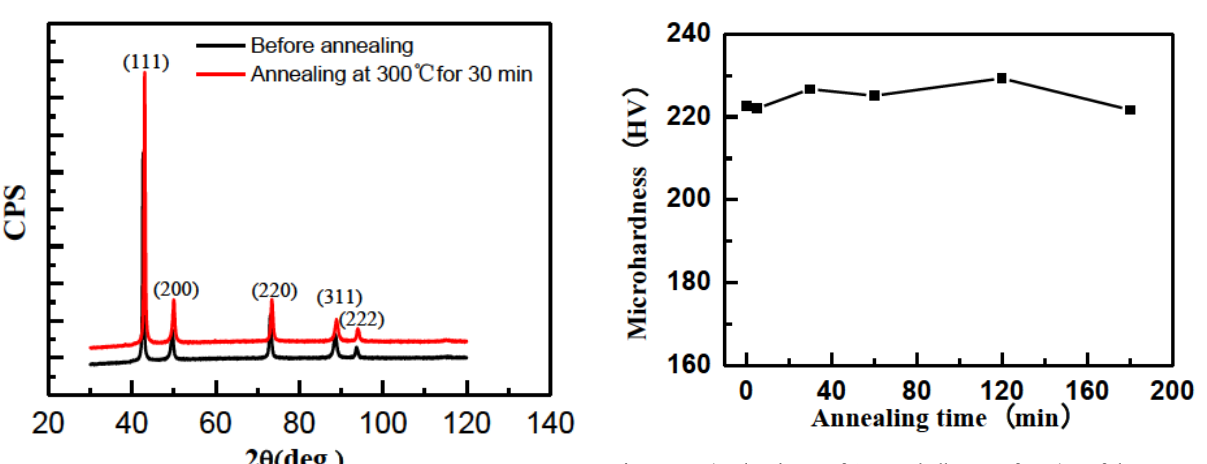
Figure 4: Microhardness of Cu-7%Al alloy as a function of the an- nealing time.